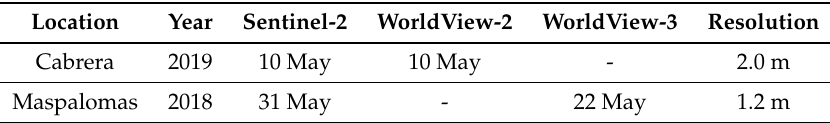
Table 3. W-S Set2: WorldView and Sentinel-2